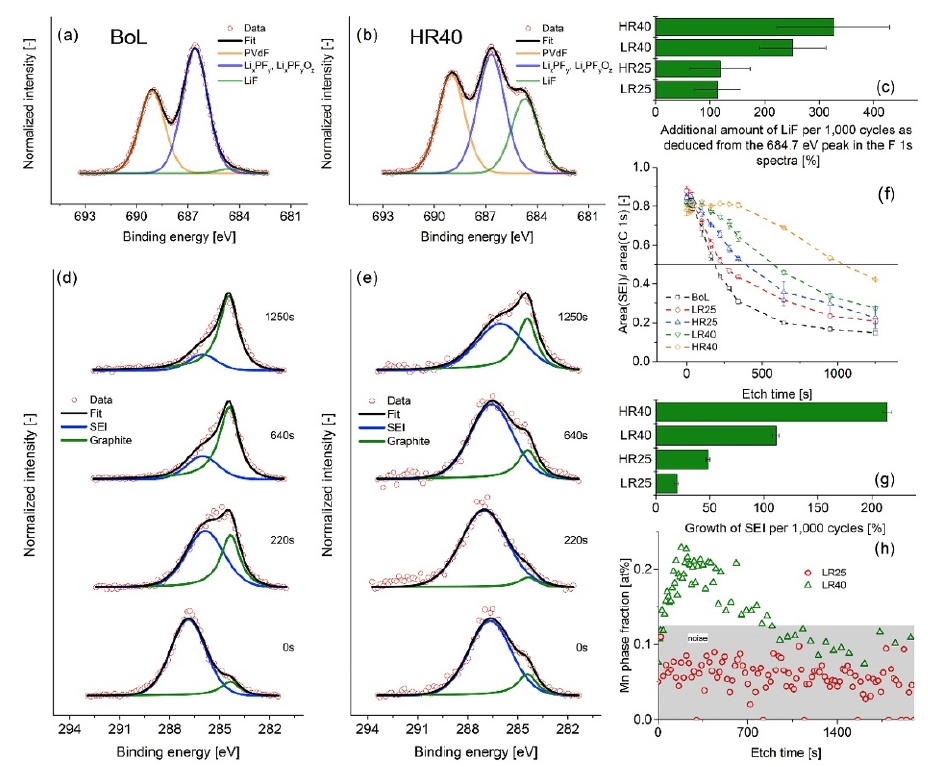
Figure 15. The spectra of F 1s from: ( a ) BoL; ( b ) HR40; ( c ) comparison in all anodes. The spectra of C 1s with argon sputter under variety times: ( d ) BoL; ( e ) HR40 anodes; ( f ) figure of SEI mass content related to argon etch time; ( g ) SEI thicknesses compared to BoL; ( h ) Manganese elements distribution depth in the LR25 and LR40 samples [66]. Reprint with permission [66]; Copyright 2016, Elsevier.